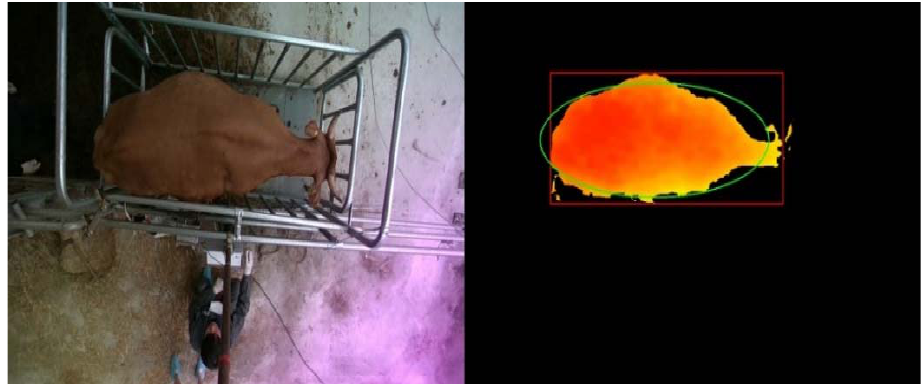
Figure 6. 3D segmented cattle image and its bounding box.